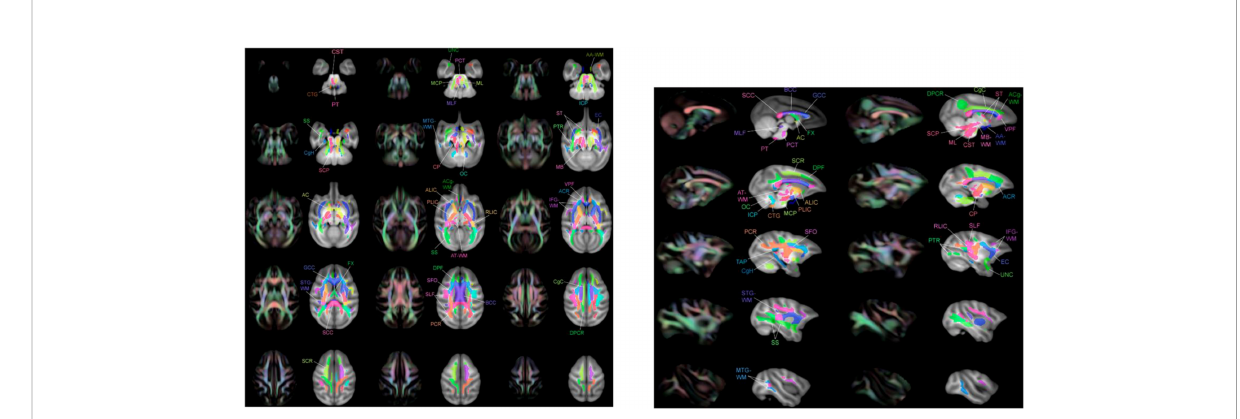
FIGURE 2 Multiple layers of the atlas overlaid with T1-W template showing regions of interest (ROIs) adjacent to the color image FA. These ROI images were taken from Zakszewski et al.